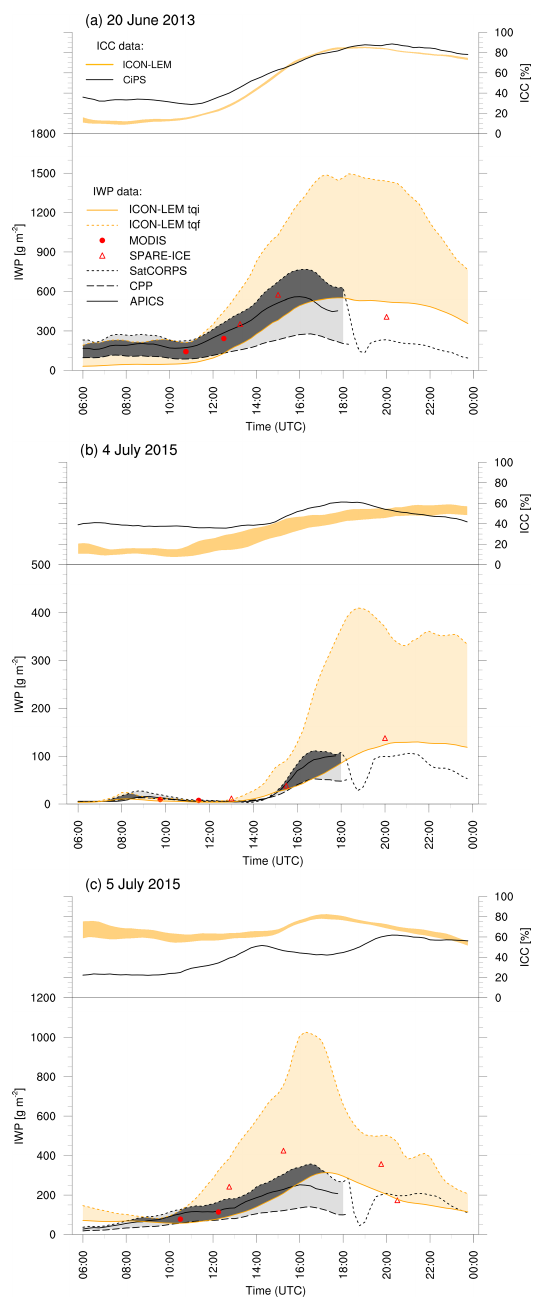
Figure 5. Temporal evolution of domain-averaged simulated ice cloud cover (ICC, right axis; top part of each figure) and integrated ice water path (IWP, left axis, bottom part of each figure) along with the corresponding satellite observations. The simulated range of ICC and IWP is displayed as the orange-shaded region, whereas the observed range of IWP by geostationary Vis–NIR retrievals is displayed in light grey. Modeled IWP is separated into two vari- ables differentiating column-integrated cloud ice crystals (tqi) with respect to all ice habits (tqf; see Sect. 4.10 for further explanation). The dark grey region shows the matching model and observational range. Symbols denote polar-orbiting IWP observations (MODIS: circles, SPARE-ICE: